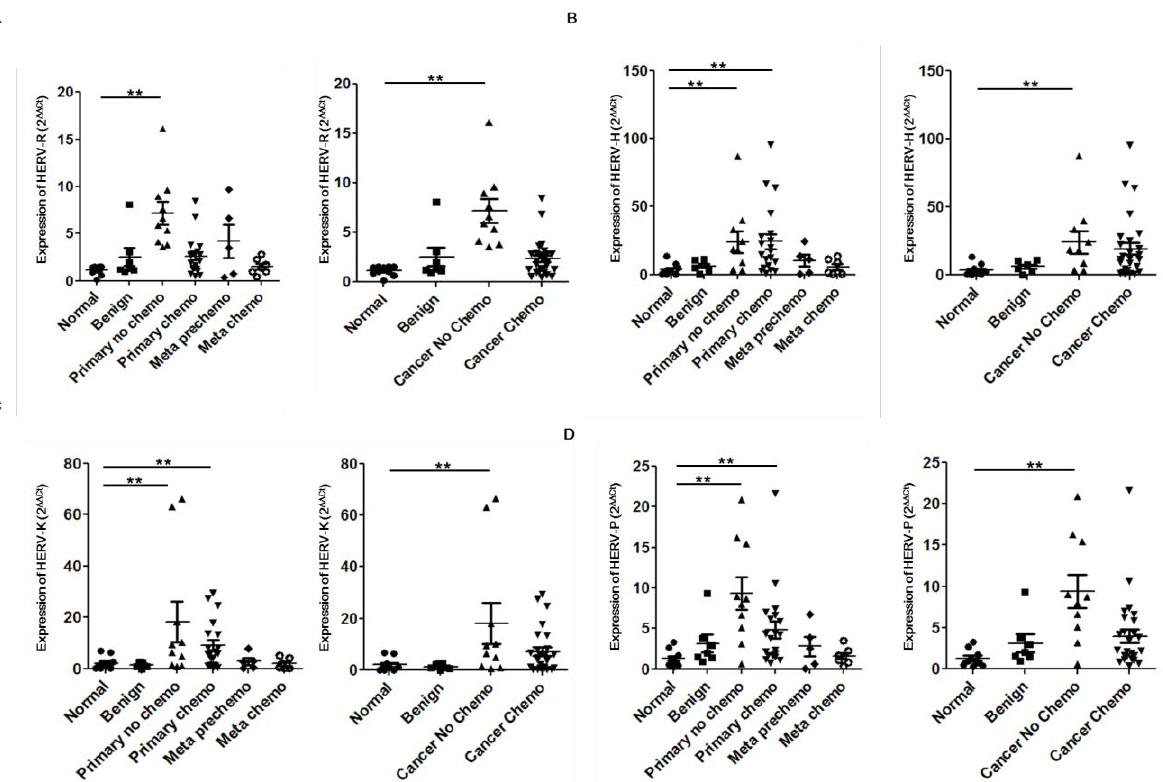
Figure 1. Expressions of HERVs env genes in the blood of breast cancer patients. Expression of the HERV-R (ERV3-1) ( A ); HERV-H ( B ); HERV-K (HML-2) ( C ); and HERV-P ( D ) env gene in the blood of breast cancer patients were analyzed by real-time PCR. Real-time PCR reactions were performed with blood total RNA of breast cancer patients including benign tumors (Benign), primary breast cancers without chemotherapy (Primary no chemo), primary breast cancers undergoing chemotherapy (Primary chemo), recurred and metastasized cancers before chemotherapy (Meta prechemo), and metastasized cancers undergoing chemotherapy (Meta chemo). Analyzed data were also compared to benign tumors (Benign), breast cancers without chemotherapy (Cancer No chemo), and breast cancers with chemotherapy (Cancer Chemo). Meta prechemo patients were ruled out in both Cancer No chemo and Cancer Chemo group because they are pre chemo stage but had experience of chemotherapy when they had primary cancer. Real-time PCR reactions were coupled to melting-curve analysis to confirm the amplification specificity. Non-template controls were included for each primer pair to check for any significant levels of contaminants. Real-time PCR was performed in three independent experiments with three different samples per group. The mRNA expression levels are presented relative to the control with calculated mean values and 95% confidence intervals. Statistical significance of differences between groups was determined using a two-tailed Student’s t -test. ** p <